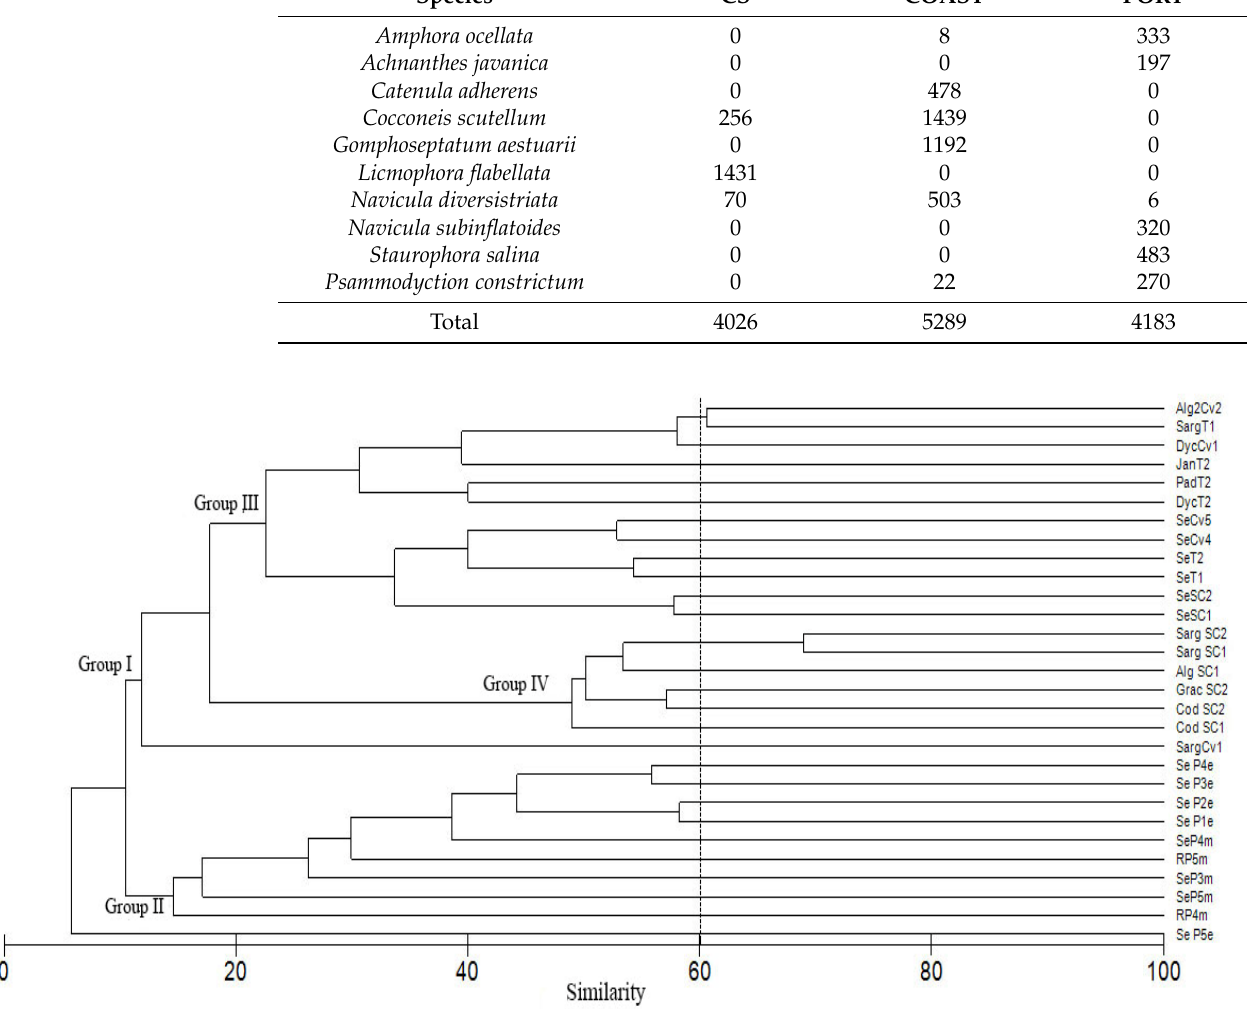
Figure 3. Bray Curtis similarity base done presence/absence data of the benthic diatom assemblages from Santa Rosalia and the control site. P = Puerto, T = Tanques, Cv = Cuevas, SC = control site, R = roca, Se = sediment, Jan = Jania , Sarg = Sargassum , Dyc = Dyctiota , Pad = Padina , Grac = Gracilaria , Cod = Codium .